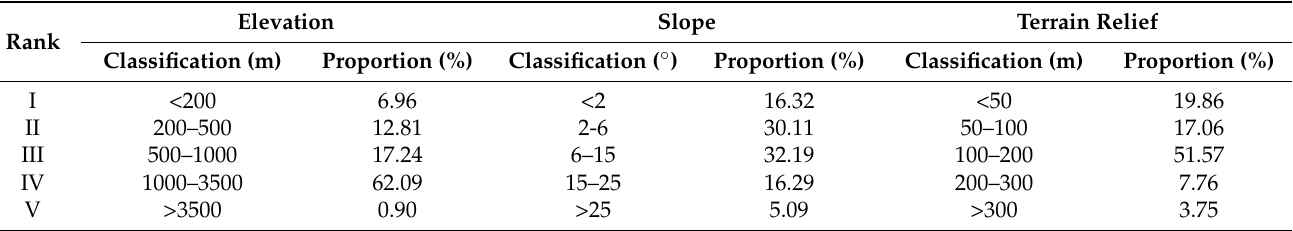
Table 2. Classification and area proportion of digital elevation model (DEM), slope, and terrain